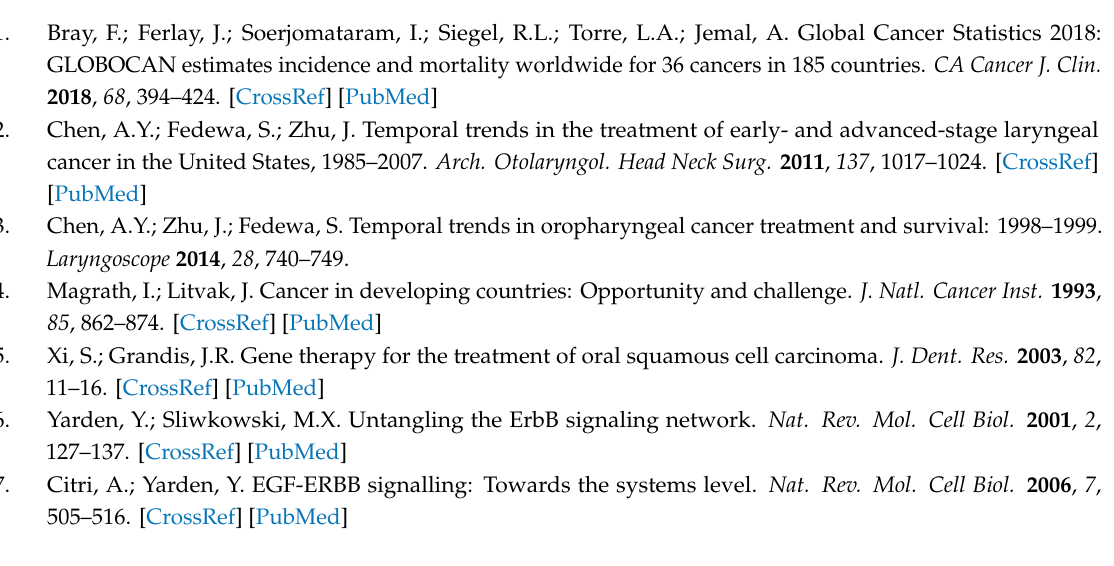
Figure S1: MTS assay data for cetuximab and AG1478 treated cells reflect cell